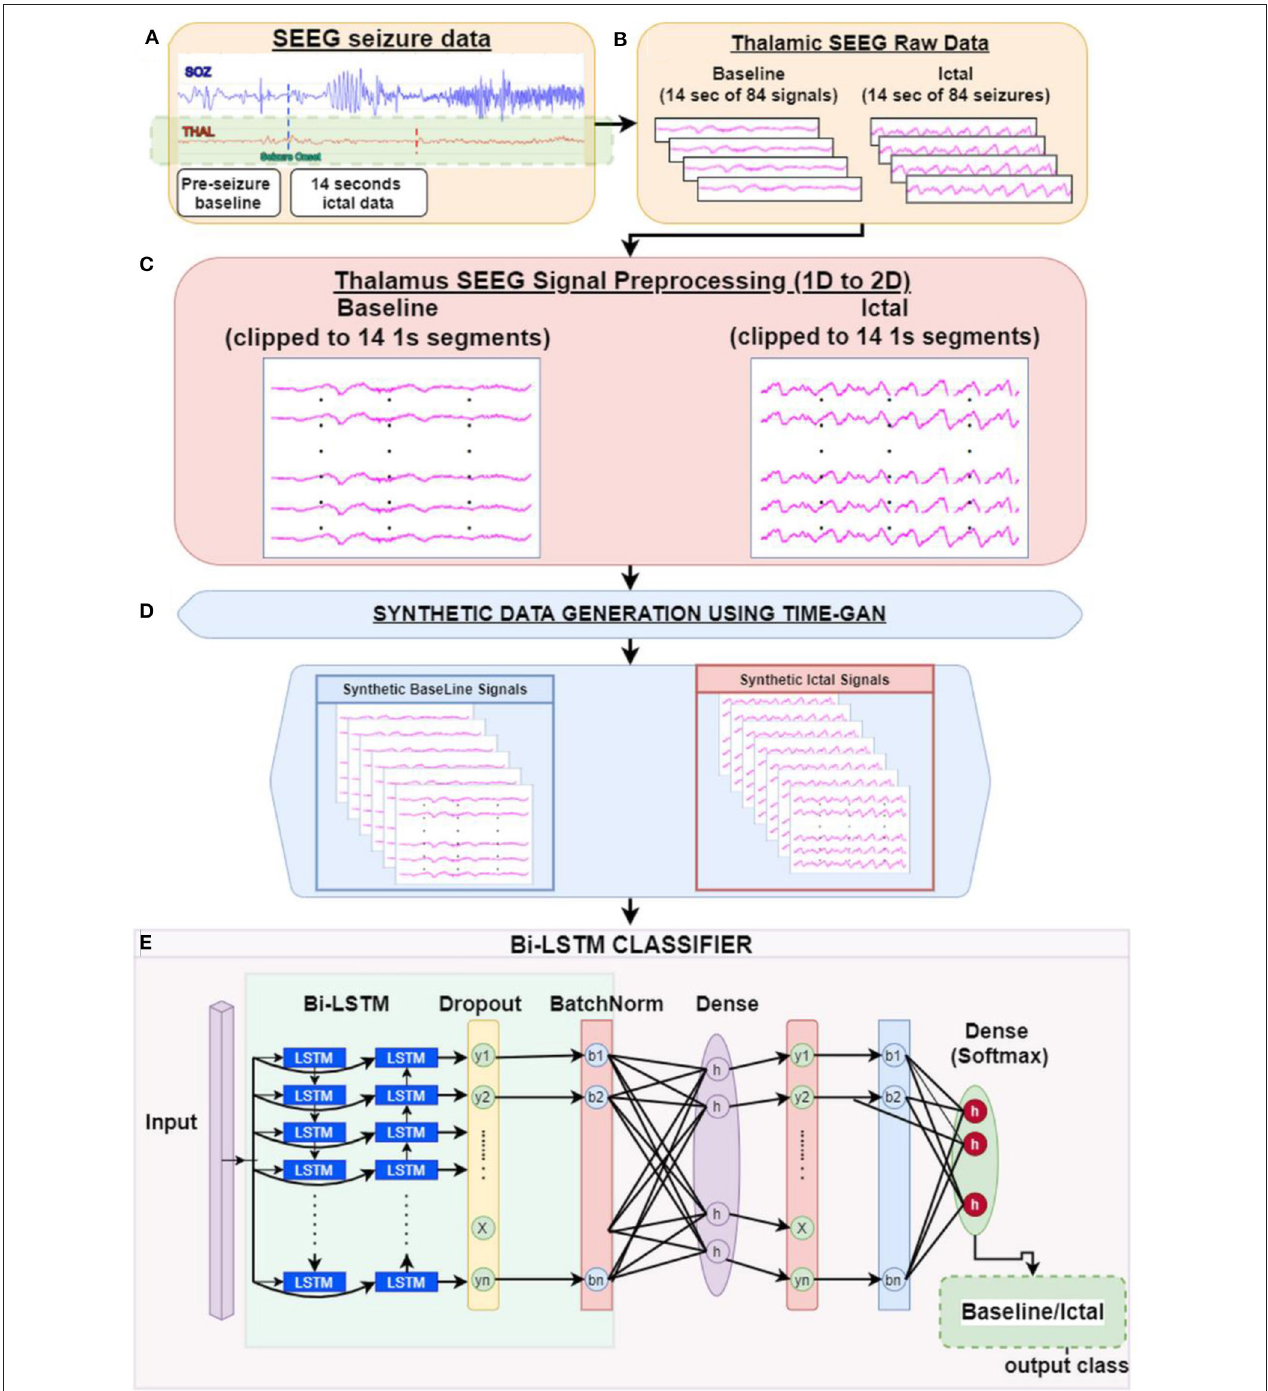
FIGURE 1 | Study pipeline: (A) Clinician identified seizure onset timings in the hippocampal-amygdalar complex were determined. We then clipped thalamic EEG segments into epochs of baseline and seizure onset. (B) Each epoch consisted of 14s of raw thalamic EEG segments (C) . As an initial step, each 14-s 1D signal epoch was fragmented into 1-s segments to generate a 2D matrix of time × signal (sampling rate: 2,048 samples/s) (D) . The data was then submitted to the TGAN system to generate synthetic data at the individual subject level. TGAN is expected to generate synthetic data that mimics original data and augment the sample size required for deep learning. (E) Two separate bidirectional long short-term memory (BiLSTM) models were tested independently on original and synthetic data.